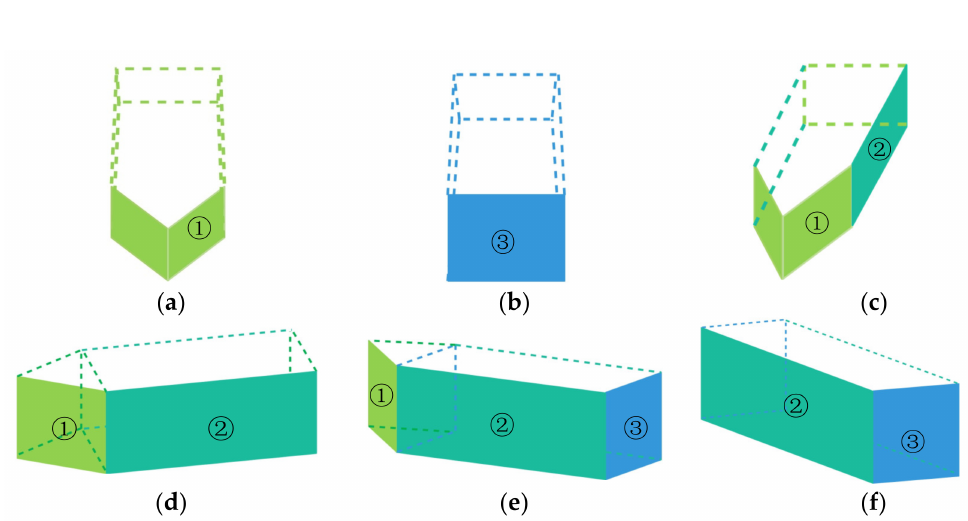
Figure 6. Relative positions of the ship and scanner: ( a ) only the bow is in sight; ( b ) only the stern is in sight; ( c ) the bow and hull are in sight; ( d ) part of the bow and hull are in sight; ( e ) part of the bow, hull, and stern are in sight; ( f ) the hull and stern are in